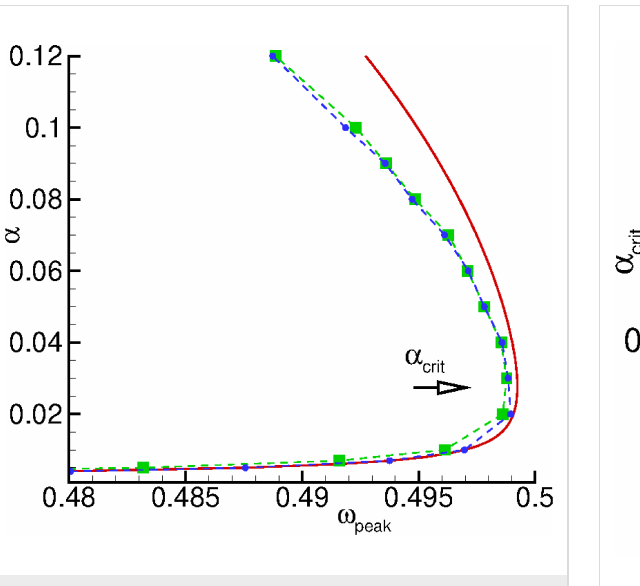
Figure 10: The dependence of the resonance maximum of ( V ) on α in the damping parameter interval [0.001–0.12]. Green squares show results calculated numerically according to the full system in Equation 6, blue circles show results calculated numerically according to the generalized Duffing and Josephson equations (Equation 17 and Equation 19). The dashed line connects the symbols to guide the eyes. The solid line show the analytical dependence on α calculated accord- ing to Equation 22. All calculations have been carried out with β c = 25, G = 0.05, r = 0.05, and ω F = 0.5.